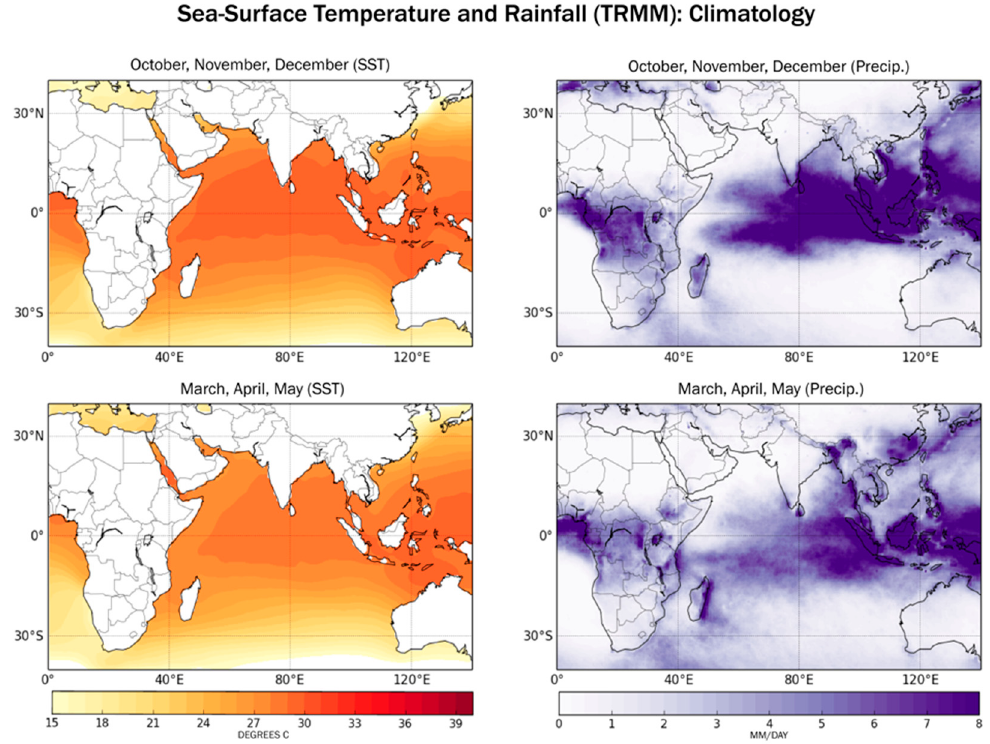
Figure 7. The climatology of sea surface temperature (HadISST, °C) and TRMM rainfall (mm/day) over the Indian Ocean during both rainy seasons. The East Indian Ocean is warmer than the West Indian Ocean. Moisture transport to East Africa is linked to this temperature gradient.